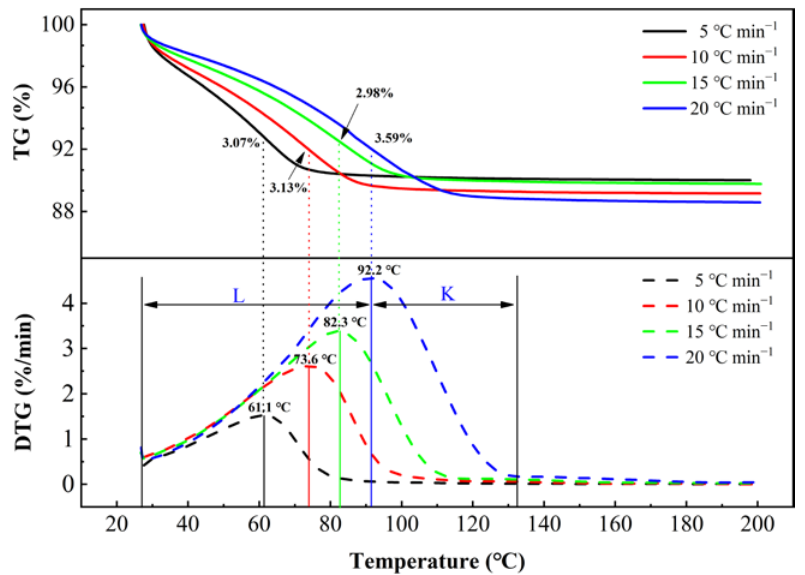
Figure 4. TG and DTG curves of soil samples dried at different heating rates of 5, 10, 15, and 20 °C min −1 (20 °C min −1 is used to illustrate the segmentation, where L = warm-up period; and K = falling rate period). K = falling rate